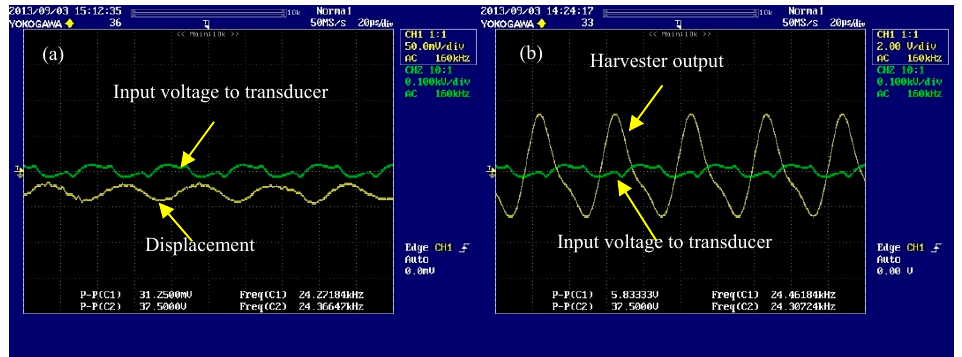
Figure 6. Displacement and open circuit voltage of the energy harvester, ( a ) Displacement in response to the input voltage; ( b ) Harvester output in response to the input voltage.